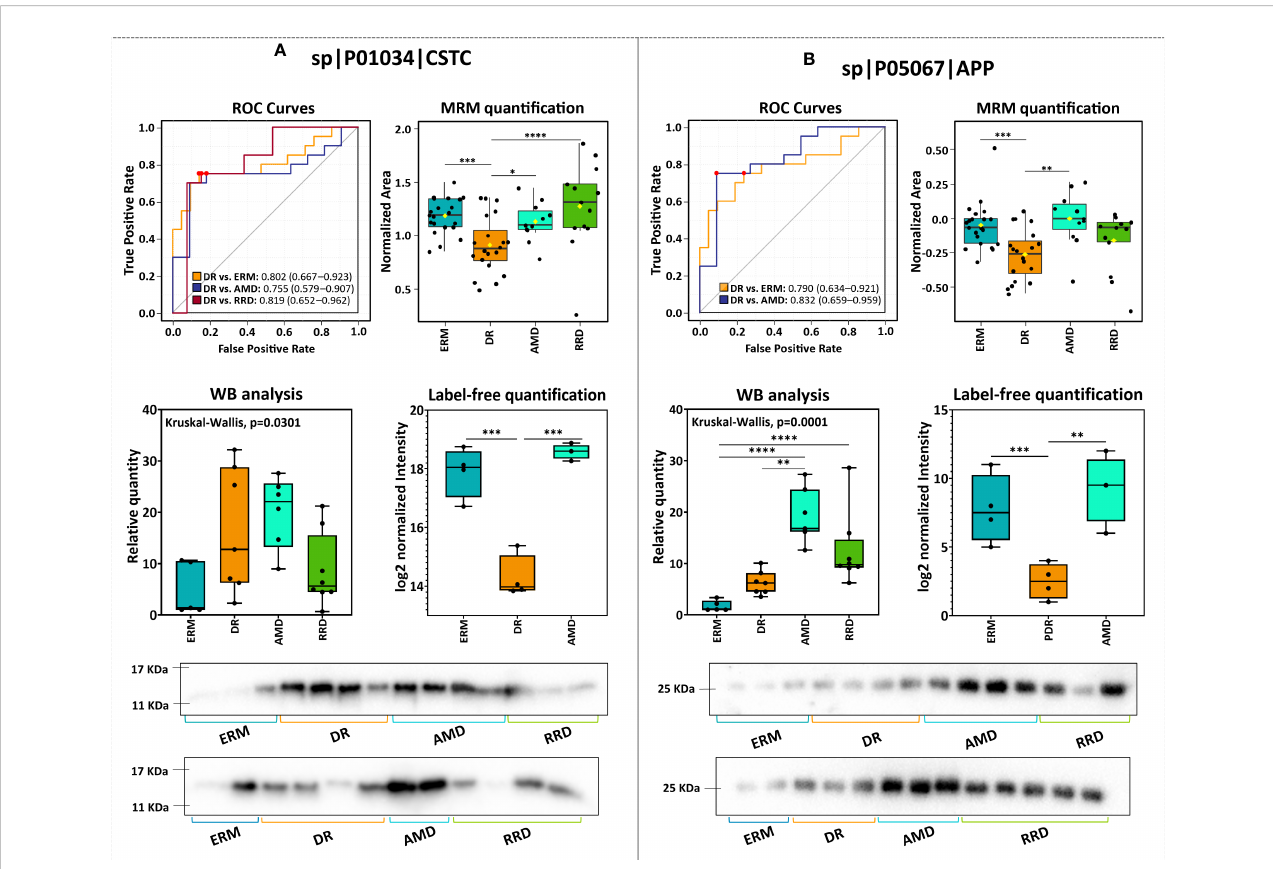
FIGURE 5 Comparison of the results of the analysis of (A) cystatin-C (CST3) and amyloid-beta (APP) by label-free quantitation (LFQ), multiple reaction monitoring (MRM), and western blot (WB), and respective ROC